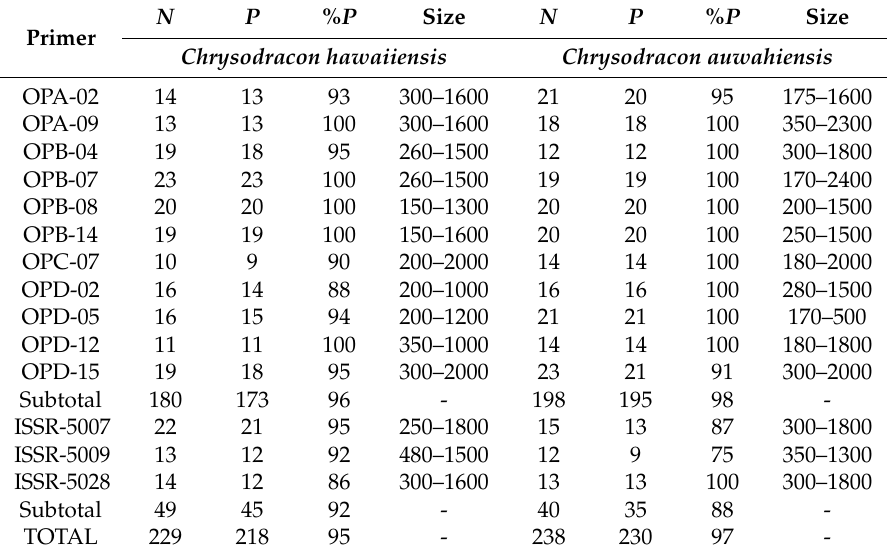
Table 1. Random amplified polymorphic DNA (OPA-OPD) and inter simple sequence repeat primers examined and the number of genetic markers scored. Primer name, number of total scored amplification products ( N ), number of polymorphic bands ( P ), percent polymorphism (% P ), and the range of size (in base pairs) for amplified products (size) for Chrysodracon auwahiensis and Chrysodracon hawaiiensis . Subtotal for RAPD and ISSR primers separately; and total for RAPD and ISSR primers